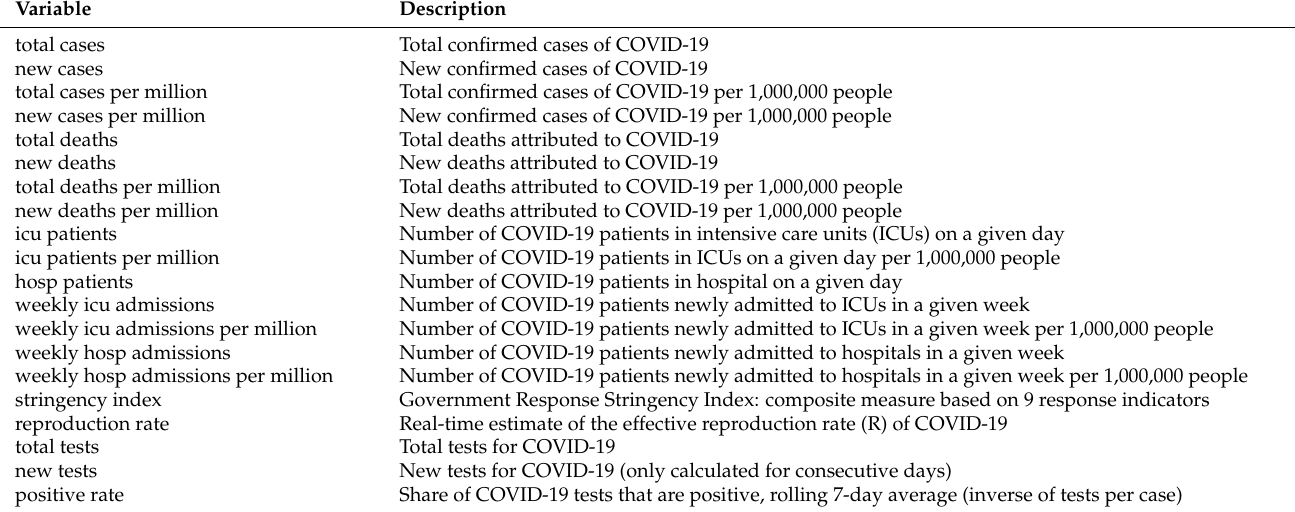
Table 3. OWID COVID-19 Dataset Feature